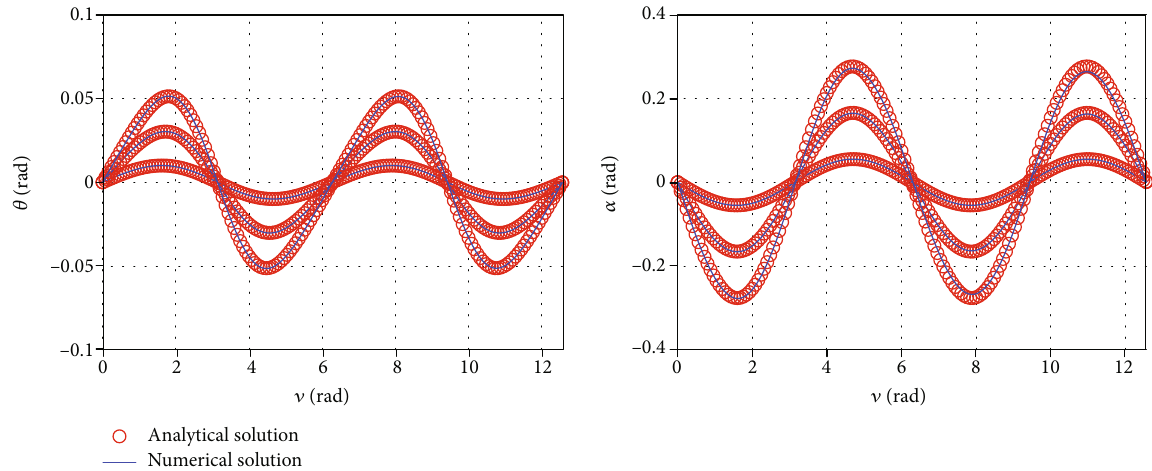
Figure 12: Periodic solutions given by asymptotic expansions and numerical results for di ff erent values of e under CR1.